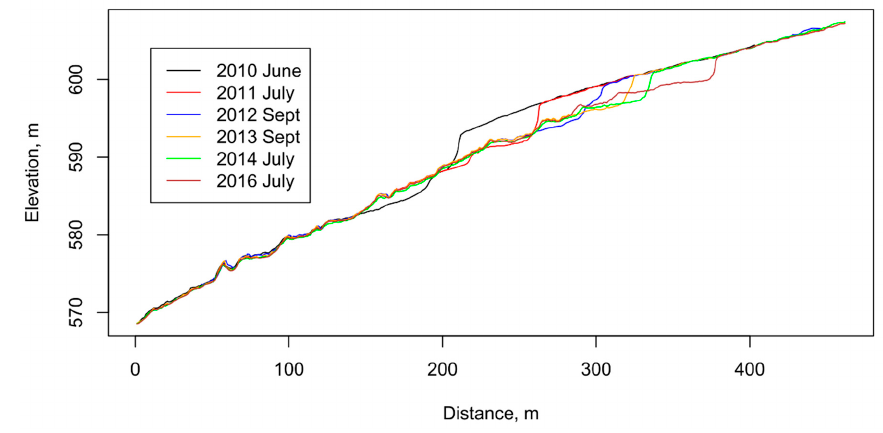
Figure 10. Topographic cross-sections of slump NOAT070, 2010–2016.